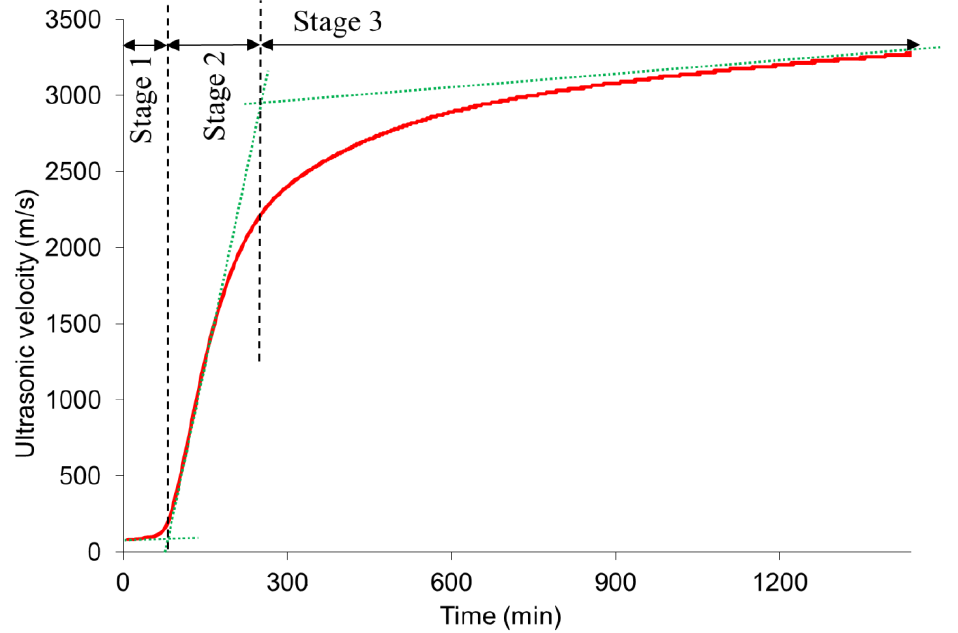
Figure 3. Typical ultrasonic velocity curve (TM 9).